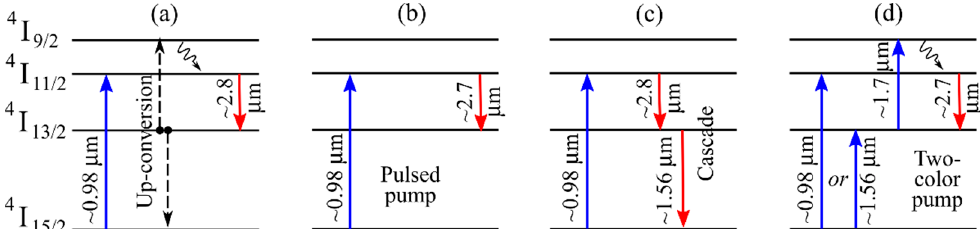
Figure 5. Schematic of different ways of effective population of the 4 I 11/2 level of Er 3+ ions in tellurite glasses. ( a ) 1. Up-conversion for very high Er 3+ ion concentrations. ( b ) 2. Pulsed pump. ( c ) 3. Dual- glasses. ( a ) 1. Up-conversion for very high Er 3 + ion concentrations. ( b ) 2. Pulsed pump. ( c ) 3. wavelength cascade lasing. ( d ) 4. Two-color pump.